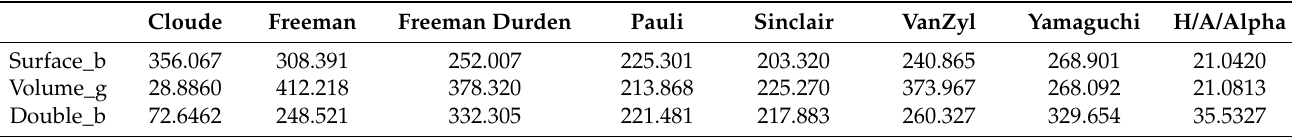
Table 4. The SNR values of the feature components